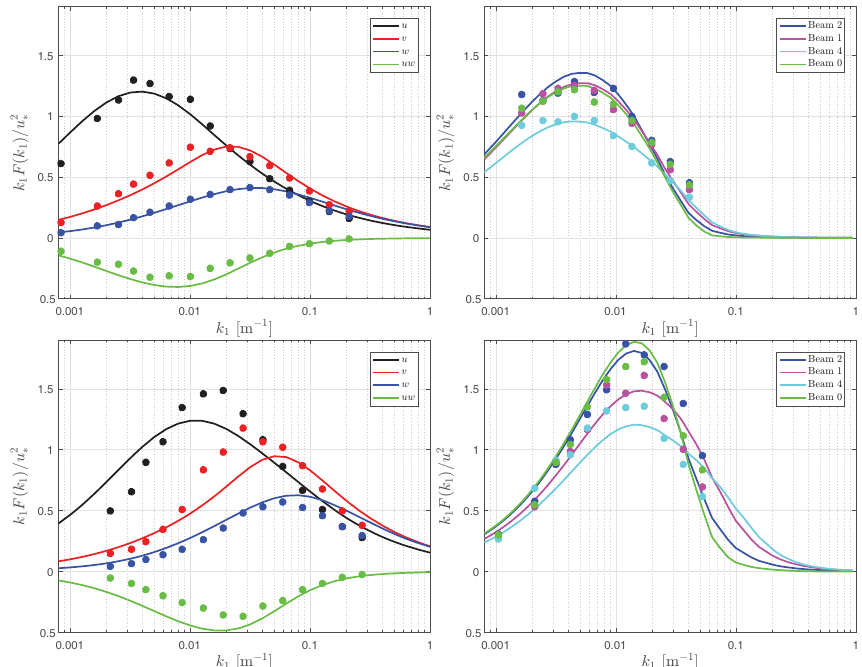
Figure 17. Normalized power spectra of the different velocity components based on the sonic-anemometer observations (left) and of the Avent radial velocity for different beams (right). The top panels show the results for the first stability range (stability 1) and the bottom panels for the last stability range (stability 5).